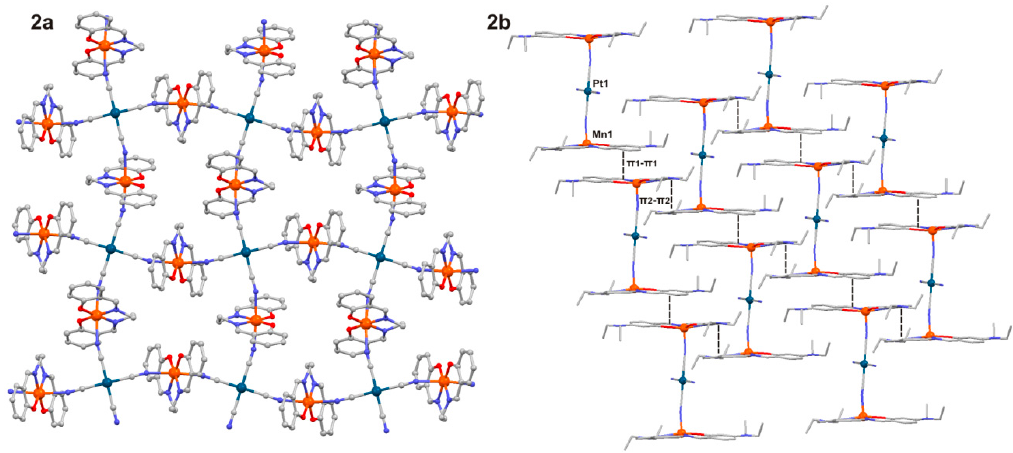
Figure 2. Fragments of the crystal structures of the complexes 2a and 2b . The hydrogen atoms are omitted for clarity. Several π – π stacking are displayed in the complex 2b (black dashed lines).